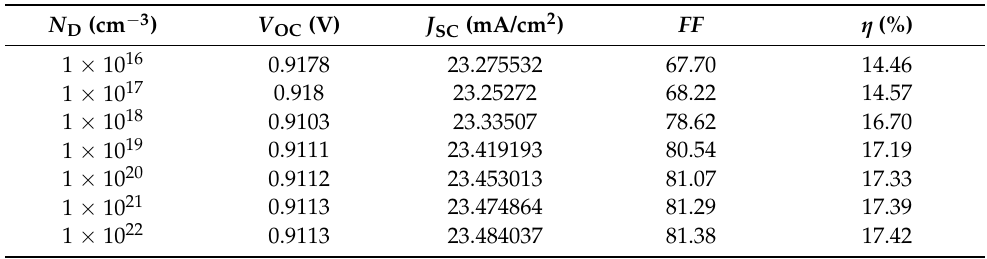
Table 6. Effective of the donor charge carrier concentration ( N D ) on the electrical cell performance parameters, at T = 300